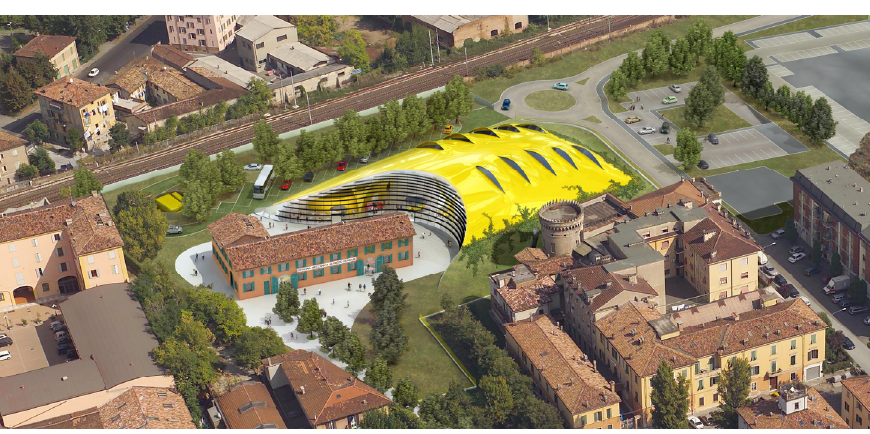
Figure 9: Ferrari & Maserati Museum, Modena